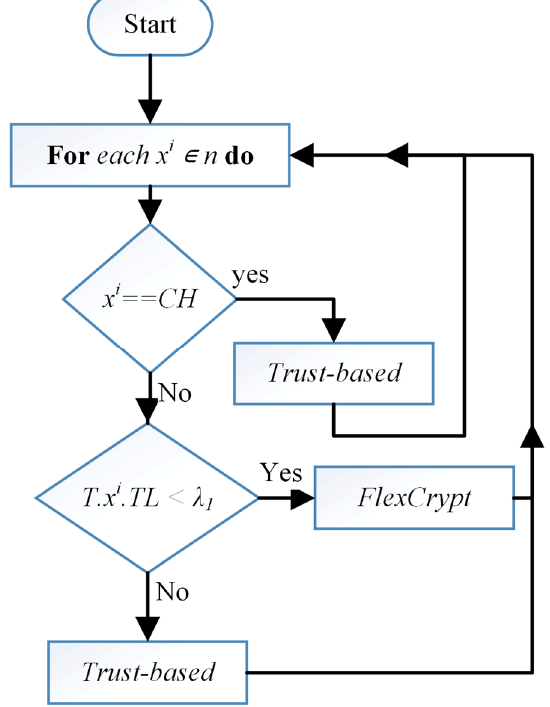
Figure 4. Flowchart of security procedure in WSN nodes.